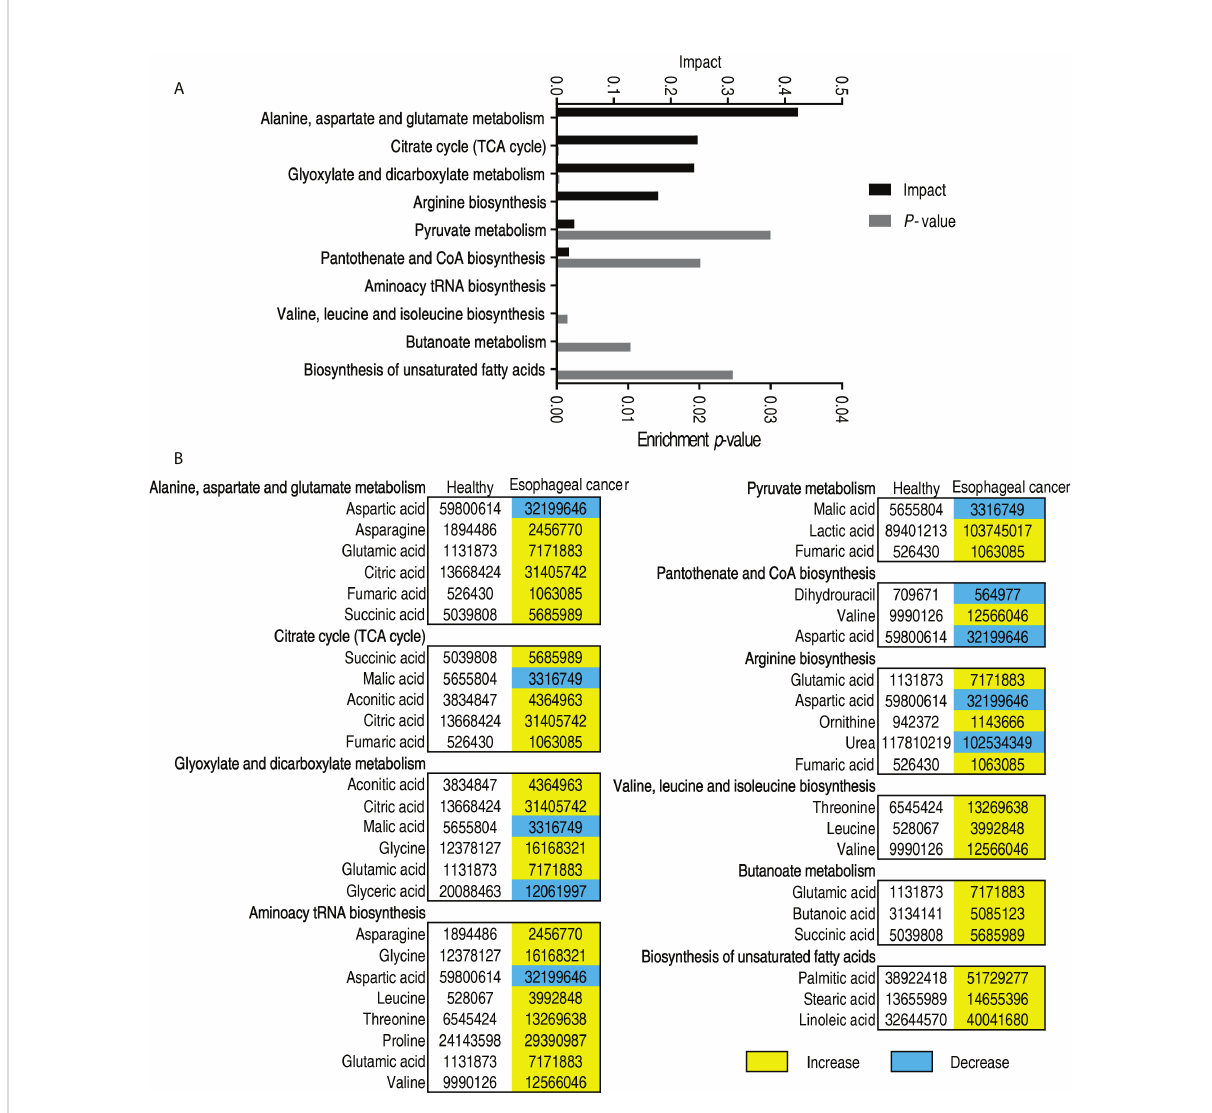
FIGURE 3 Pathway analysis of patients with esophageal cancer. (A) Pathway enrichment of differential abundant metabolites. (B) The volume of the differential metabolites of patients with esophageal cancer compared with normal individuals. Yellow and blue indicate increase and decrease of metabolites,